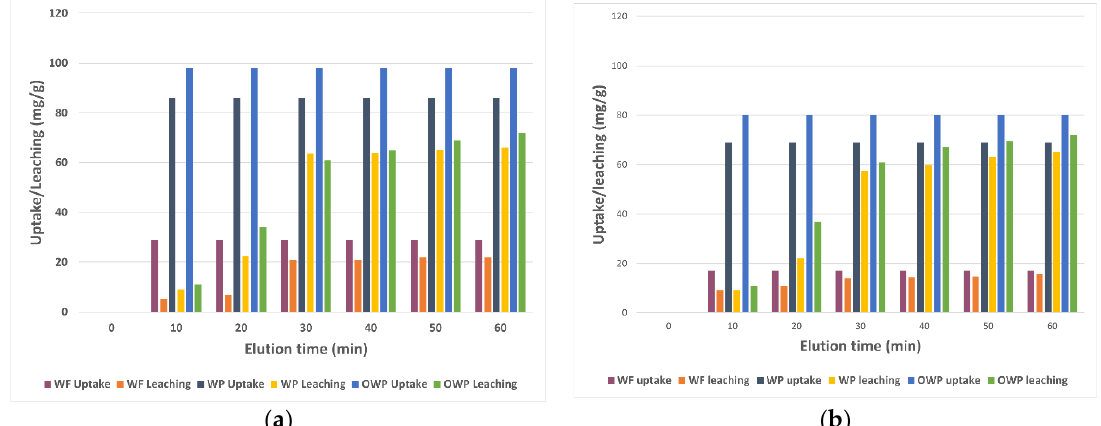
Figure 2. Efficiency on Cu 2+ ( a ) and Zn 2+ ( b ) complexation by various forms of wool. Adapted from Reference [13].